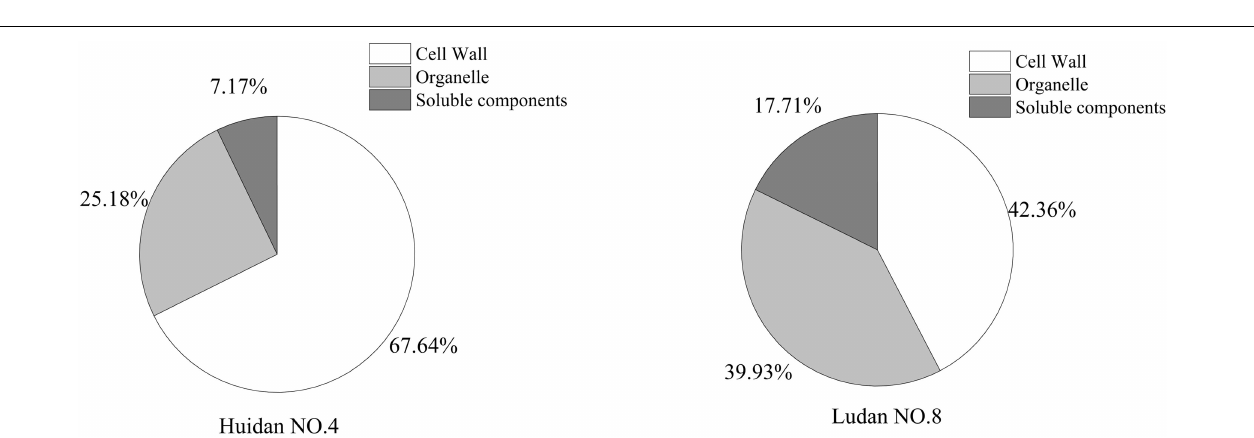
FIGURE 1 | The difference of antioxidant enzyme activity between two varieties of maize. Huidan No. 4 lead-free treatment (A) , Huidan No. 4 exposed to lead (B) , Ludan No. 8 lead-free treatment (C) , and Ludan No. 8 exposed to lead (D) . The different letters indicate the antioxidant enzyme activity are significantly different among treatments ( P < 0.05, Duncan’s Least Significant Difference).